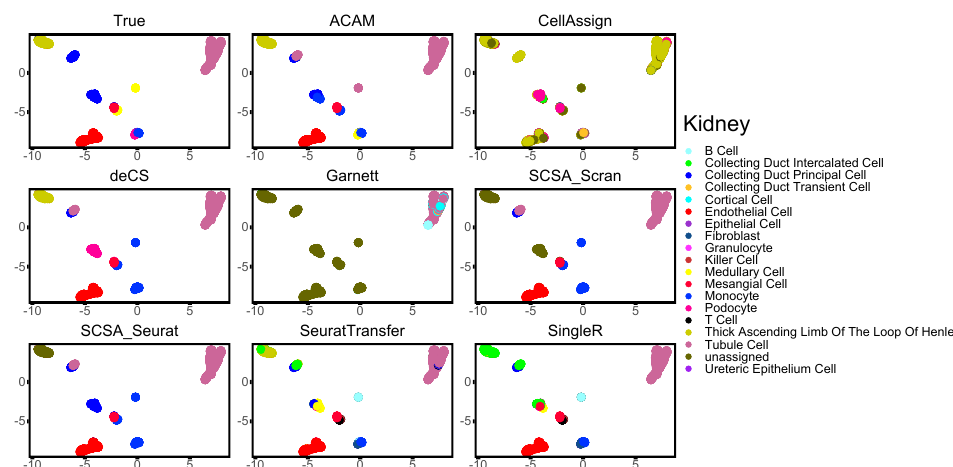
Figure 4. Two-dimensional visualization of the annotation results for dataset Kidney using UMAP.